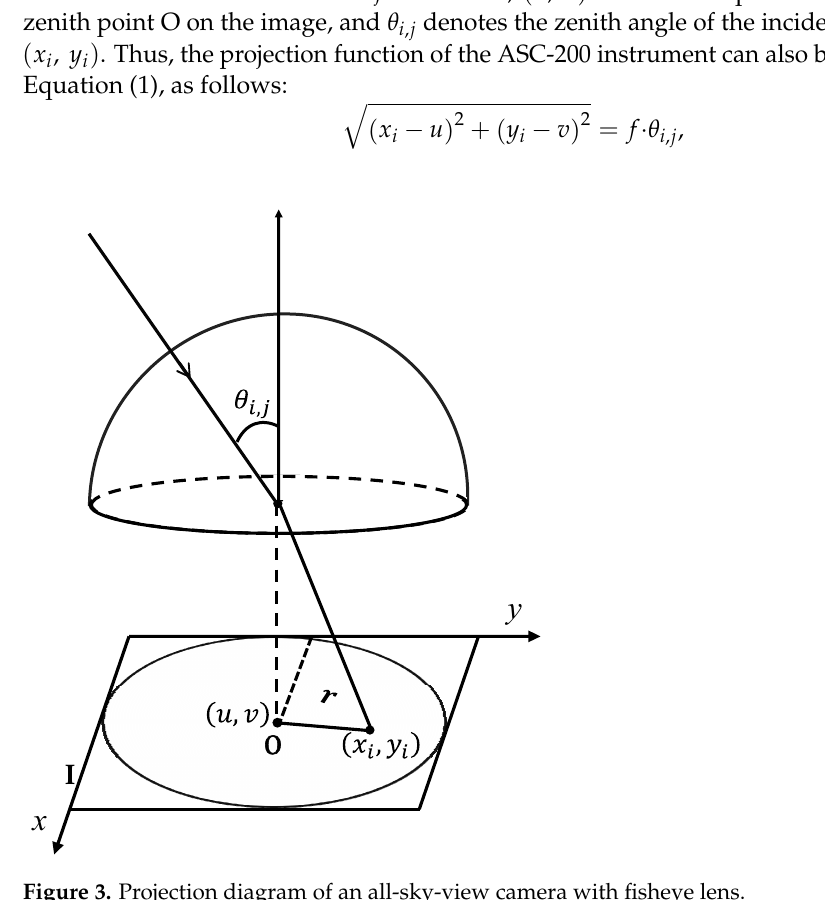
Figure 3. Projection diagram of an all-sky-view camera with fisheye lens.